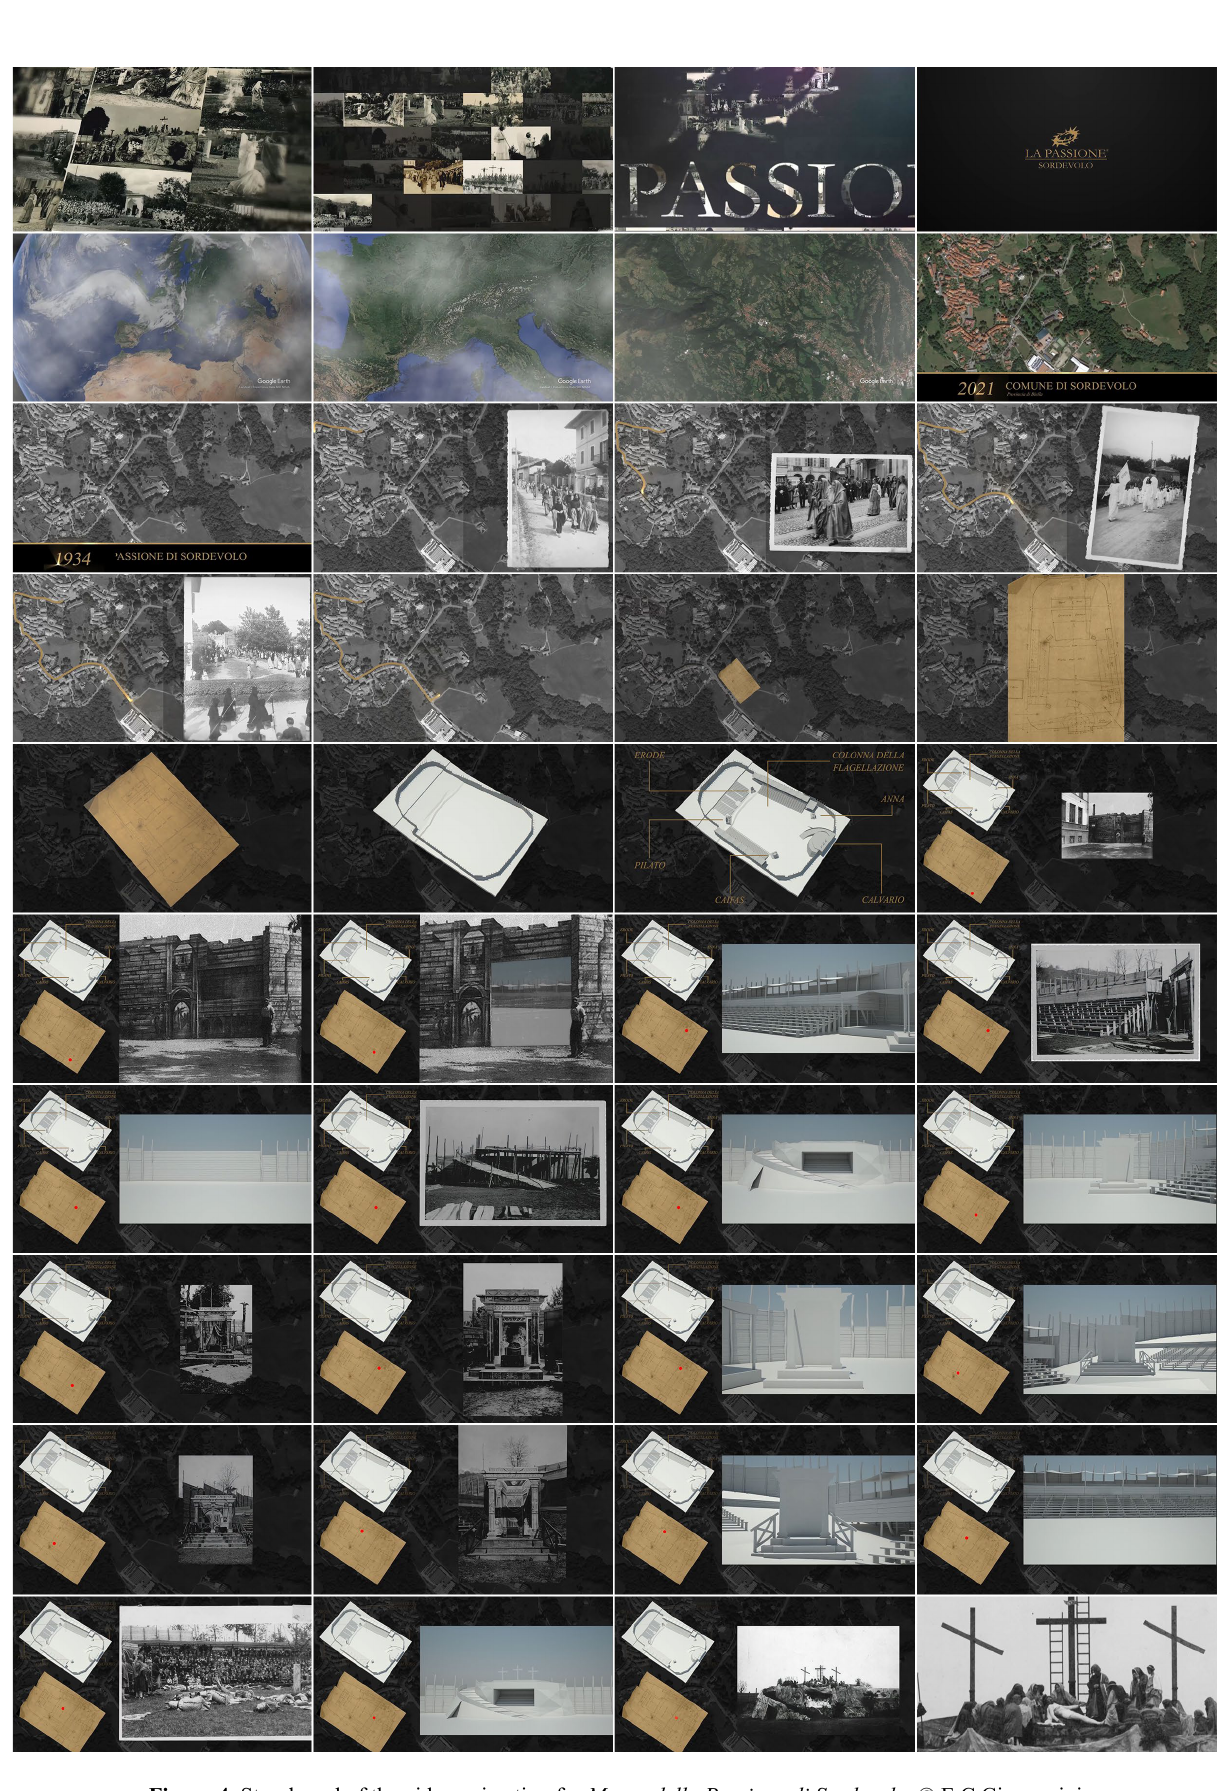
Figure 4 . Storyboard of the video animation for Museo della Passione di Sordevolo. ©